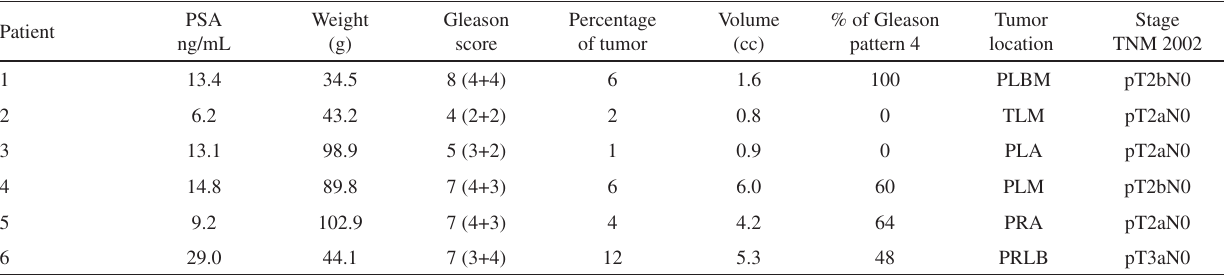
Table 3 ­ Results of radical prostatectomy of six patients